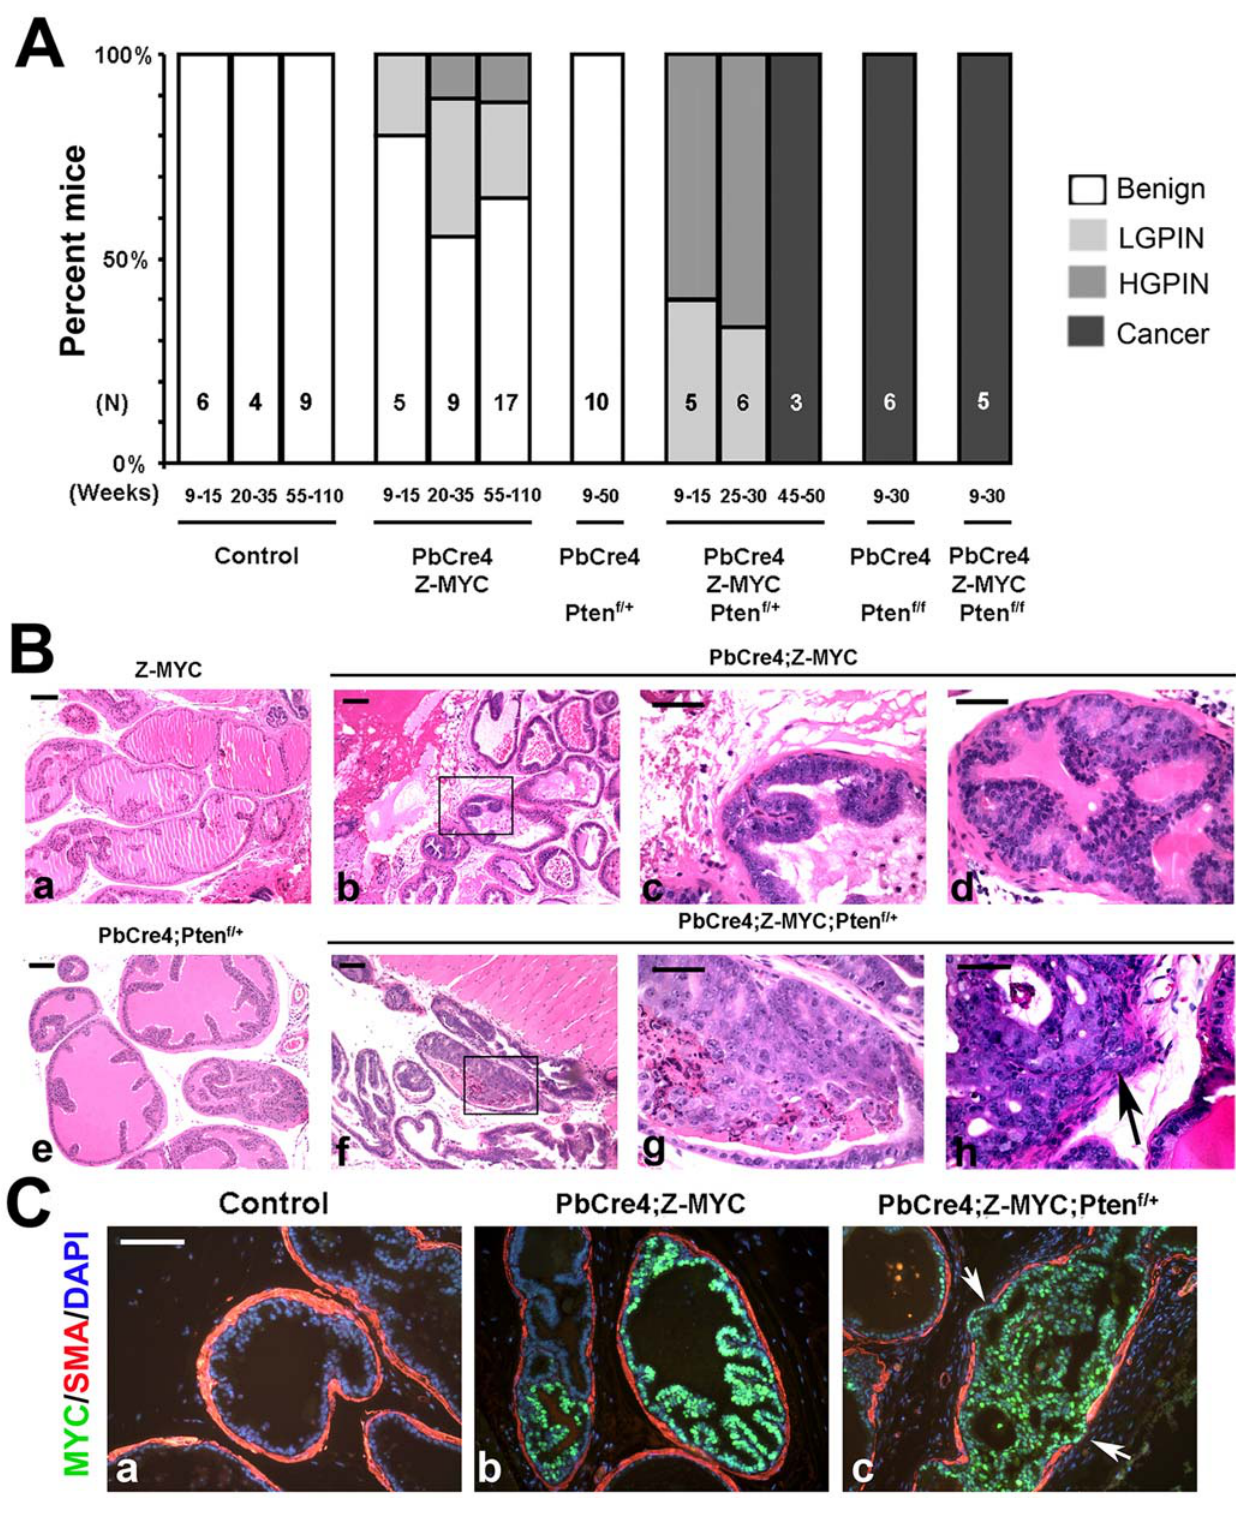
Figure 2. Pathology of PbCre4;Z-MYC and compound c-MYC/Pten mutant mice. (A) Hematoxylin and eosin (H&E)–stained prostate sections were analyzed and the summary of the pathological grading is shown. (N, number of mice analyzed). (B) Representative images of H&E-stained sections show benign glands in control (a), focal LGPIN in PbCre4;Z-MYC (boxed region in b and higher magnification in (c), focal HGPIN lesion in PbCre4;Z-MYC (d), benign glands in PbCre4;Pten f/ + (e), focal HGPIN lesions in PbCre4;Z-MYC;Pten f/ + (boxed region in f and higher magnification in g) and focal micro-invasive cancer lesion (arrow) in PbCre4;Z-MYC;Pten f/ + (h). Scale bars: 100 m m in (a,b,e,f) and 50 m m in (c,d,g,h). (C) c-MYC and smooth muscle actin (SMA) staining. Arrows in (c) indicate focal areas of disruption of SMA (micro-invasion) in PbCre4;Z-MYC;Pten f/ + prostate. Scale bar: 100 m m.